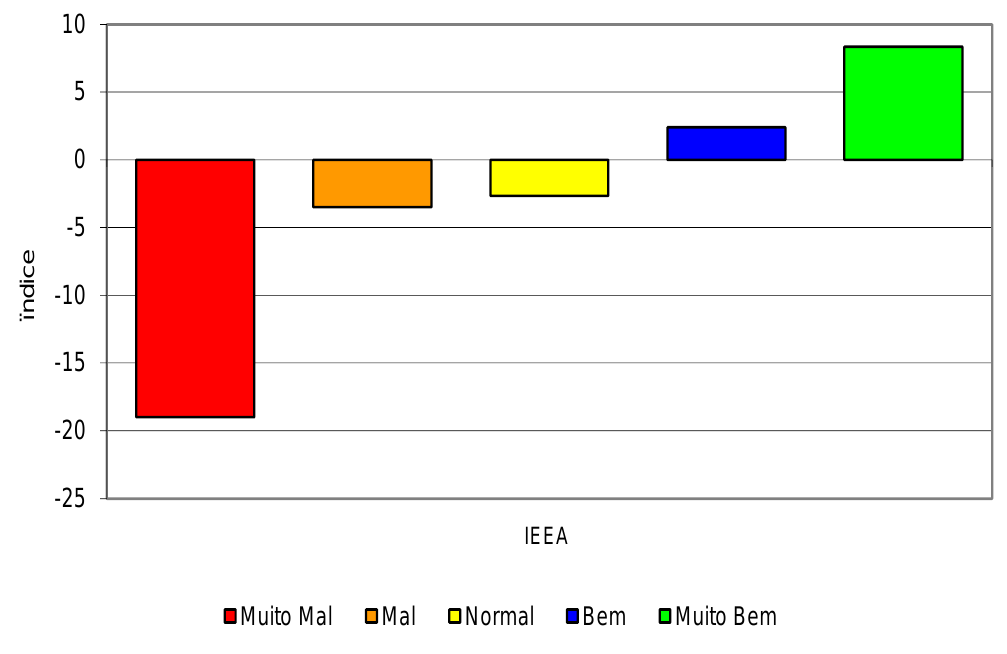
Figura 2. IEEA para o fator “Como você está se sentindo em relação à sua convivência em casa com seus pais, irmãos e